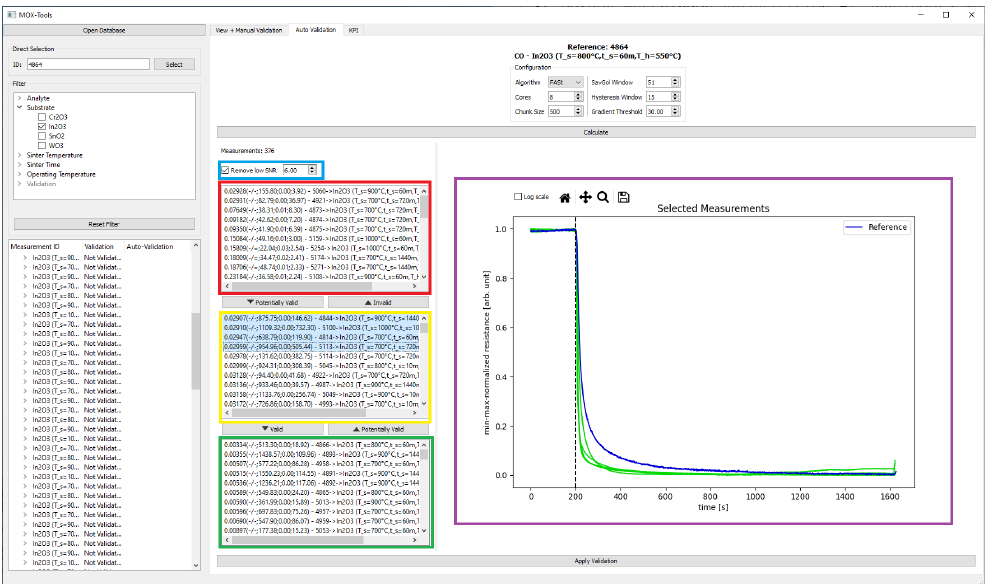
Figure 4. Exemplary use of the auto validation function. Validation of all CO measurements per- formed with In 2 O 3 -based sensors. The blue curve is the user-supplied reference, the green curves are the candidates as selected in the middle (yellow rectangle) and lower list (green rectangle). The upper list (red rectangle) holds all measurements that are greater than the selected reference threshold (light blue rectangle) and are therefore sorted